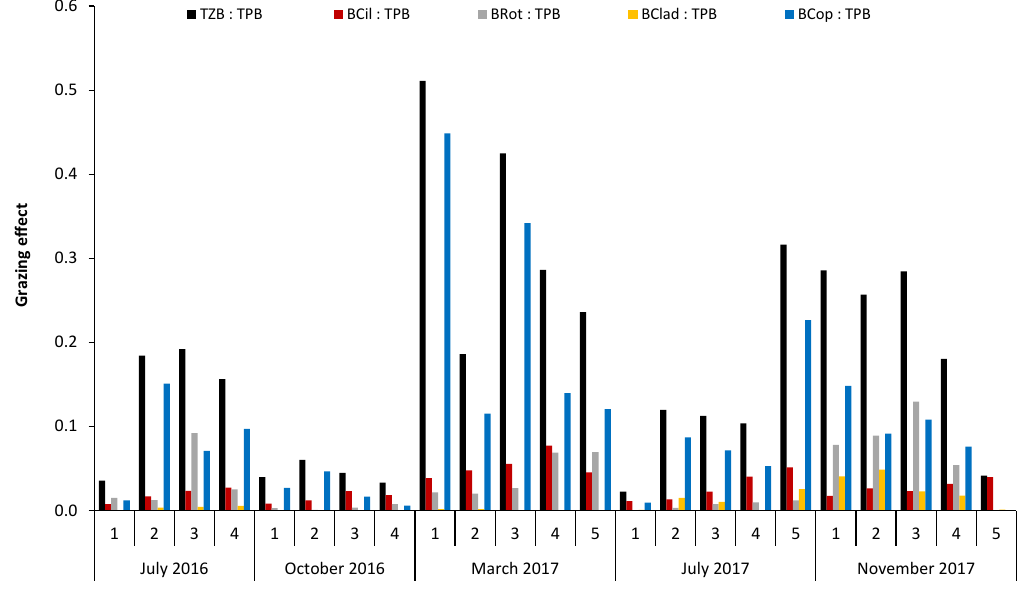
Figure 8. The zooplankton grazing e ff ect on phytoplankton including biomass ratios; TPB—total phytoplankton biomass, TZB—total zooplankton biomass, BCil—ciliate biomass, BRot—rotifer biomass, BClad—cladoceran biomass, BCop—copepod biomass, sites 1–4 in Lake Warnołty, site 5 in Lake Śniardwy.